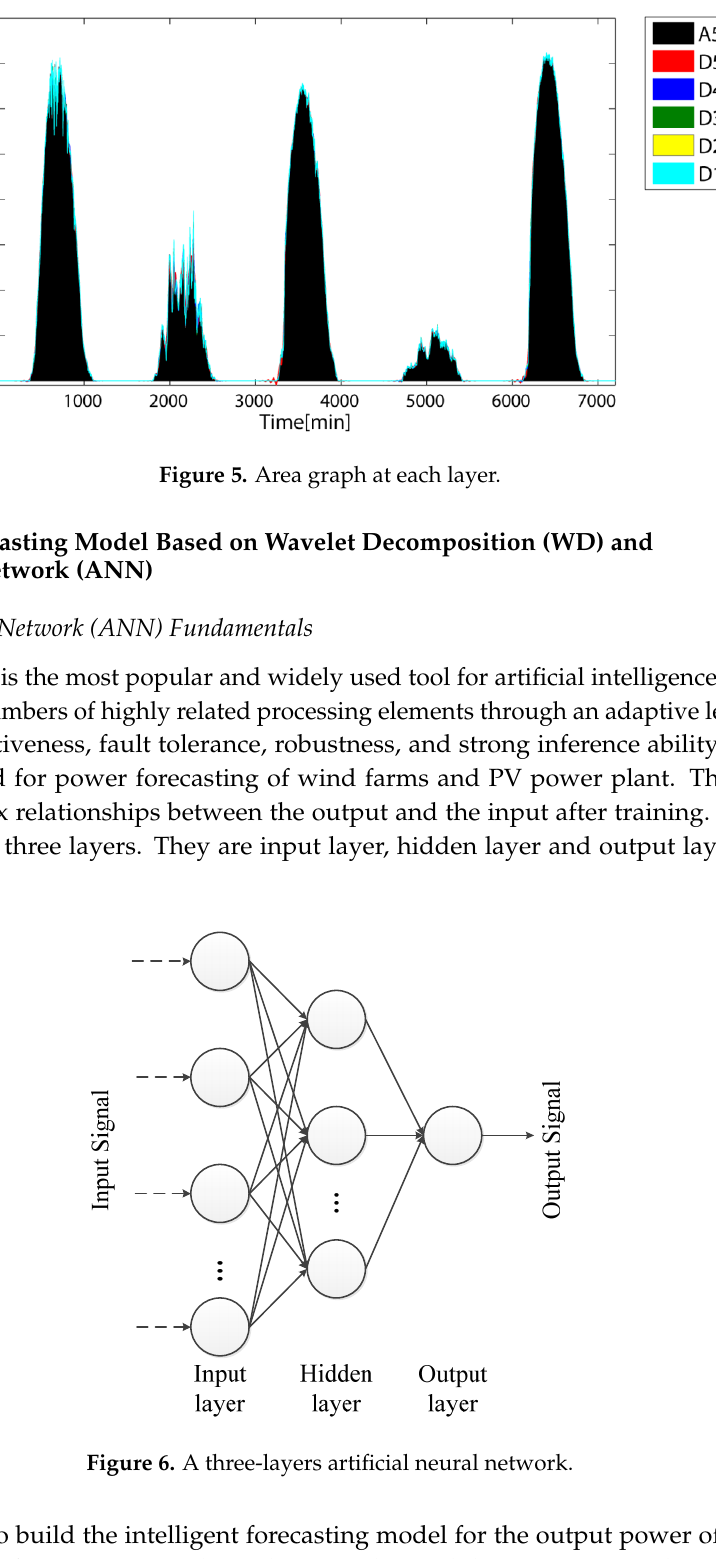
Figure 6. A three ‐ layers artificial neural network. Figure 6. A three-layers artificial neural